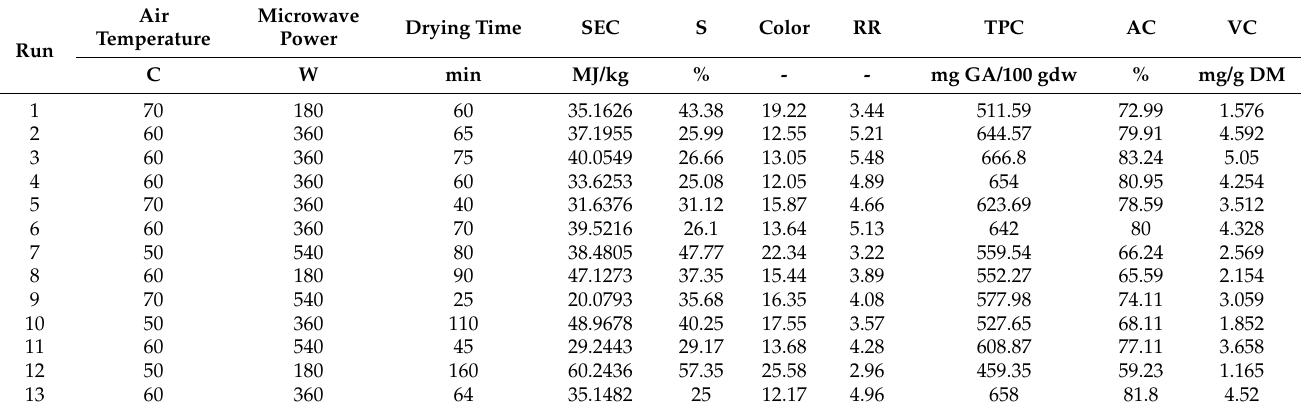
Table 3. Central composite design and experimental data obtained for the response